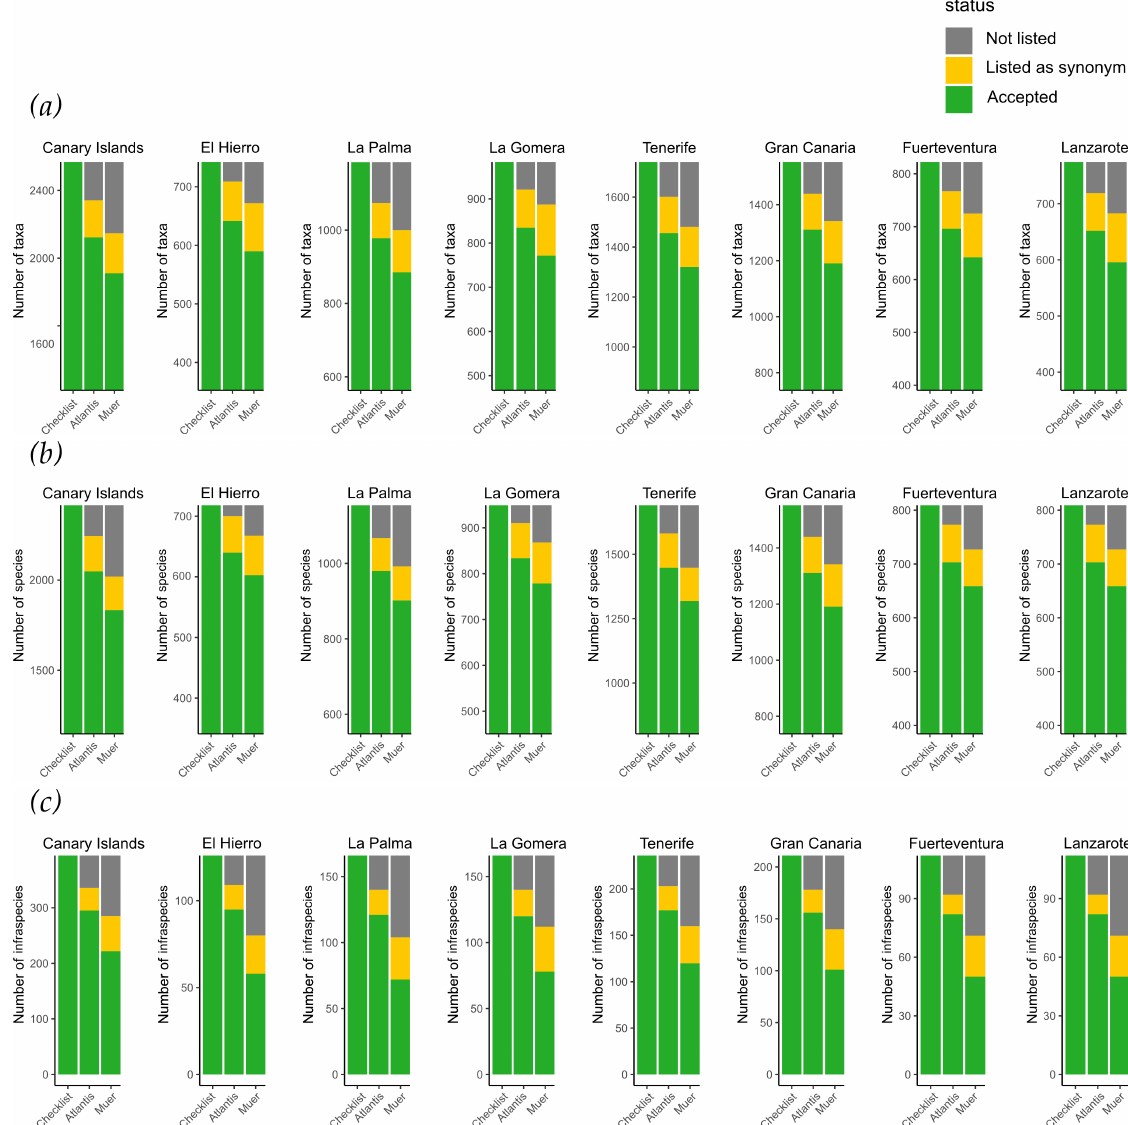
Figure 5. Comparing numbers of the here presented FloCan Checklist (without hybrid taxa, synonyms, and non-naturalized ornamental garden and park plants) with the Atlantis database [22] and with the taxa of Muer et al. [34] separately for ( a ) taxa, ( b ) species and ( c ) infraspecies (subspecies, varieties). Categories given are “not listed” in the respective database, “listed as synonym” and “accepted”. This comparison illustrates how many of the accepted taxa in FloCan are also reflected in other established